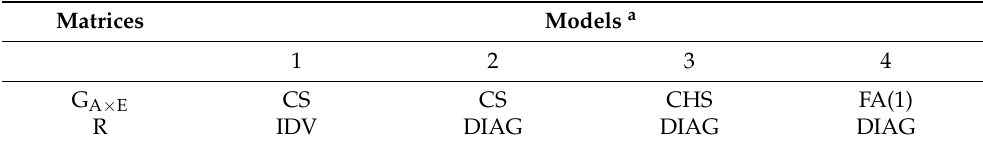
Table 1. Summary of variance-covariance structures fit in each model.